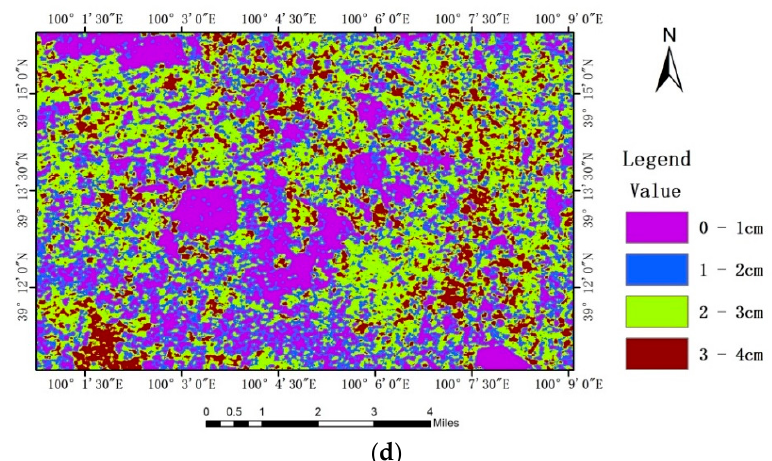
Figure 5. Distribution map of soil moisture mv and Hrms : ( a ) mv , θ = 33.5°; ( b ) mv , θ = 26.3°; ( c ) Hrms , θ = 33.5°; ( d ) Hrms , θ = 26.3°.